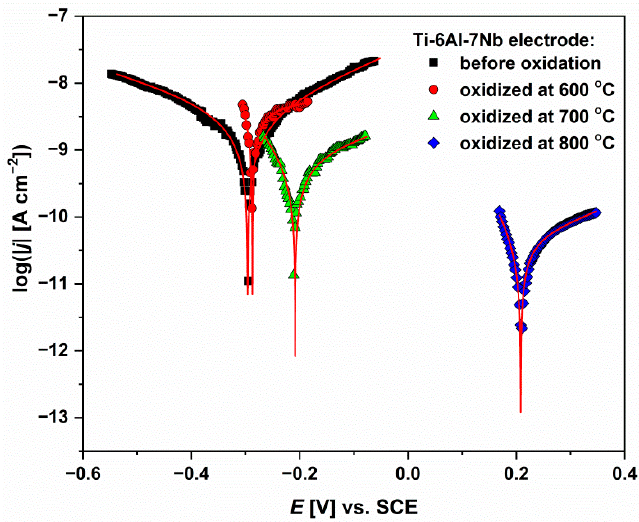
Figure 8. Tafel curves for the Ti ‐ 6Al ‐ 7Nb electrode before and after isothermal oxidation at 600, 700, and 800 ° C recorded in saline solution at 37 ° C showing experimental (symbols) and fitted data ( ─ ) using the Butler ‐ Volmer equation (B ‐ V fit).